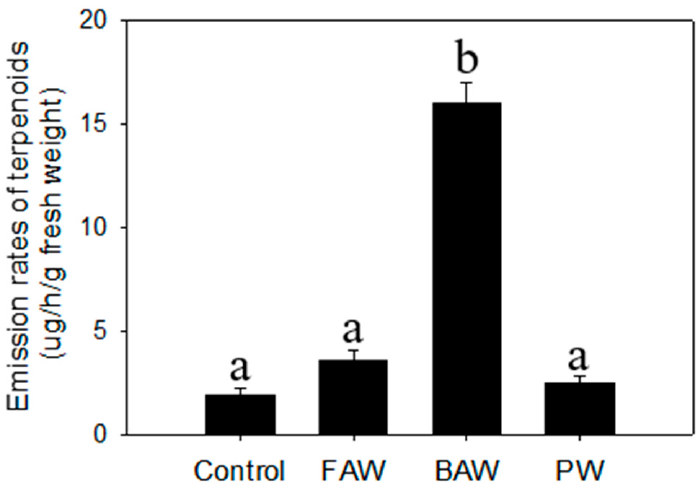
Figure 3. Emission rates of total terpenoids from physical wounding (PW), fall armyworm (FAW) and beet armyworm (BAW) from C. iria leaves. Standard error is denoted for each bar. Different letters (a and b) denote significant differences between treatments at P ≤ 0.05 according to an F-protected Tukey’s test.